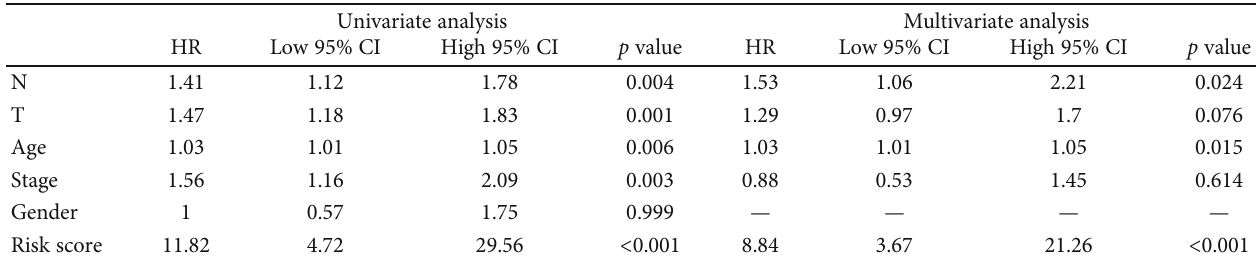
Table 2: Univariate and multivariate analyses of prognostic factors and overall survival of HNSCC patients in the GSE65858